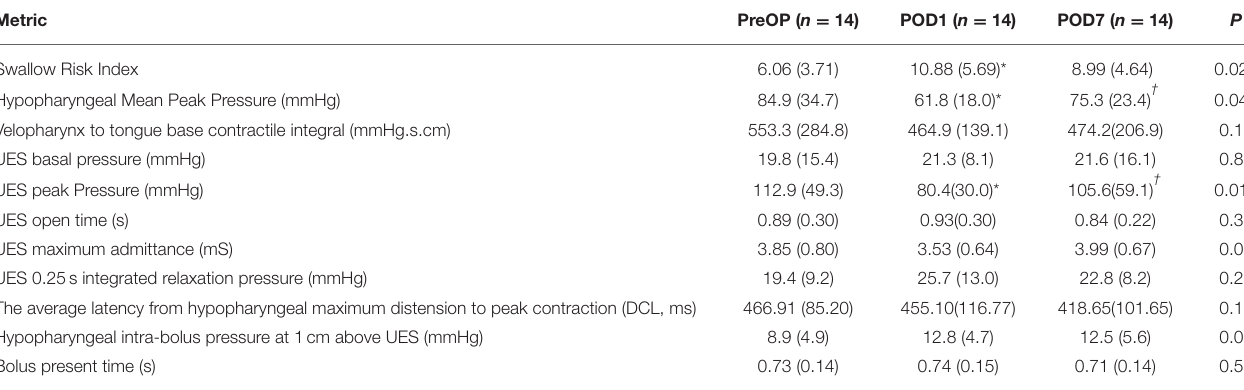
TABLE 3 | Pharyngeal and upper esophageal sphincter parameters among HRIM swallow tests while in a neutral sitting position.